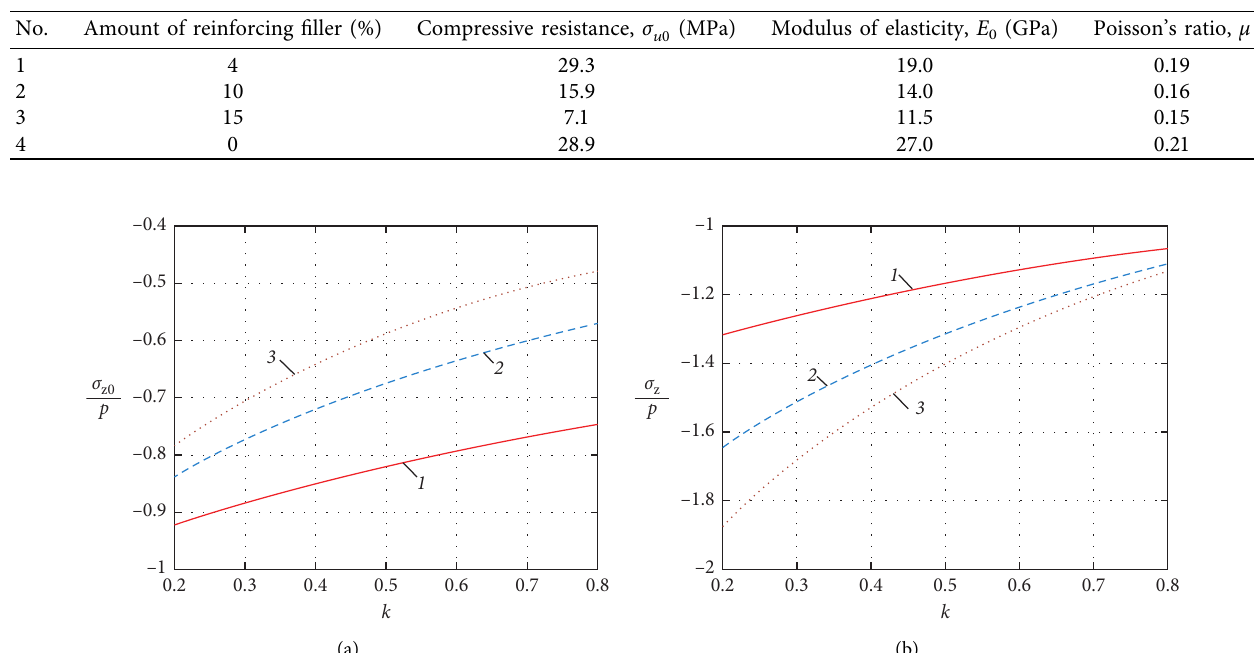
Figure 2: Axial stresses in two-layer concrete column: (a) stress in the layer of PETF concrete; (b) stress in the concrete core. –0.06–0.05–0.04–0.03-0.02–0.010 Figure 3: Contact stresses between layers of the column. Figure 4: Hoop stresses in a layer of PETF